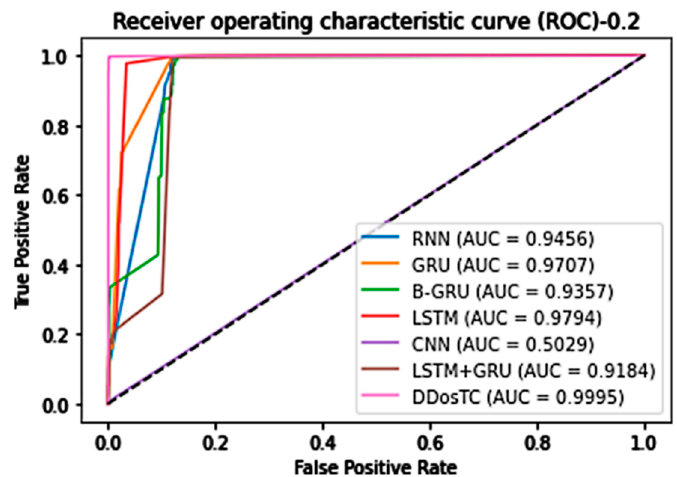
Figure 12. AUC for train/test = 8:2.